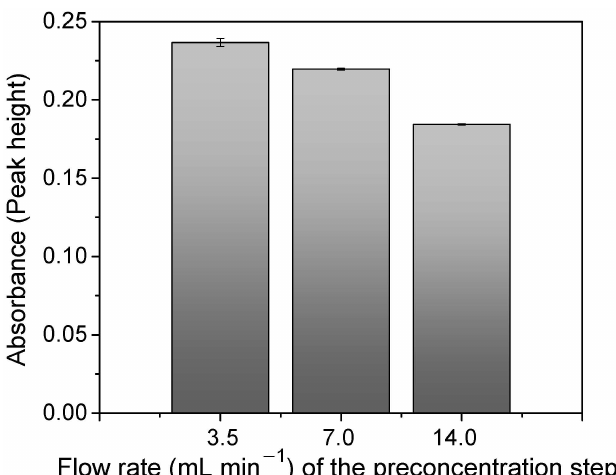
Figure 8. Optimization of sample flow rate for Cu 2+ preconcentration via FIA system. Conditions: mass of polymer = 50.0 mg; concentration of Cu 2+ = 100.0 µ g L − 1 ; sample loop = 14.0 mL; elution flow rate = 7.0 mL min − 1 ; pH = 6.0; buffer = at 0.05 mol L − 1 BR; eluent = 1.50 mol L − 1